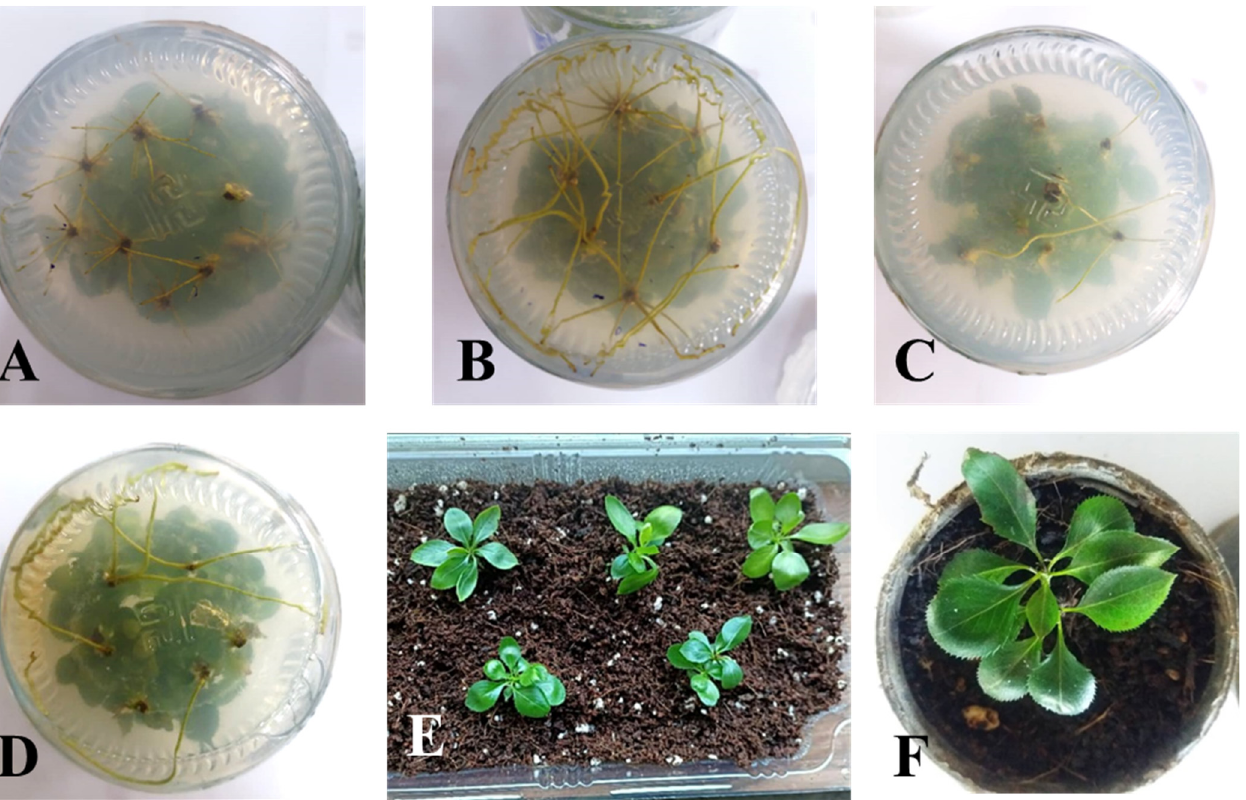
Figure 3. In vitro shoots of pear ( Pyrus communis L.) ‘Pyrodwarf ® (S)’ rootstock, after the last sub-culture. ( A ) Microshoots produced in the MS medium supplemented Figure 3. In vitro root induction in pear ( Pyrus communis L.) ‘Pyrodwarf ® (S)’ rootstock. ( A ) Rooted microshoots in the MS medium with 0.5 mg·L –1 IAA, ( B ) Rooted with 1 mg · L − 1 BA, ( B ) Microshoots produced in the MS medium with 2 mg · L − 1 BA and 0.5 mg · L − 1 Kin, ( C ) Microshoots produced in the MS medium with 2 mg · L − 1 microshoots in the MS medium with 1 mg·L –1 IAA, ( C ) Rooted microshoots in the MS medium with 0.5 mg·L –1 IBA, ( D ) Rooted microshoots in the MS medium BA and 1 mg · L − 1 Kin, ( D ) Microshoots produced in the WPM medium with 1 mg · L − 1 BA, ( E ) Microshoots produced in the WPM medium with 2 mg · L − 1 BA and with 1 mg·L –1 IBA, ( E ) Hardening of plantlets in plastic dishes filled with perlite and cocopeat (in a ratio of 1:3) in the acclimatization room, ( F ) Plantlets transferred 0.5 mg · L − 1 Kin, ( F ) Microshoots produced in the WPM medium with 2 mg · L − 1 BA and 1 mg · L − 1 Kin. Scale bar = 10 to plastic pots (after 20 days) for further acclimatization in the greenhouse.